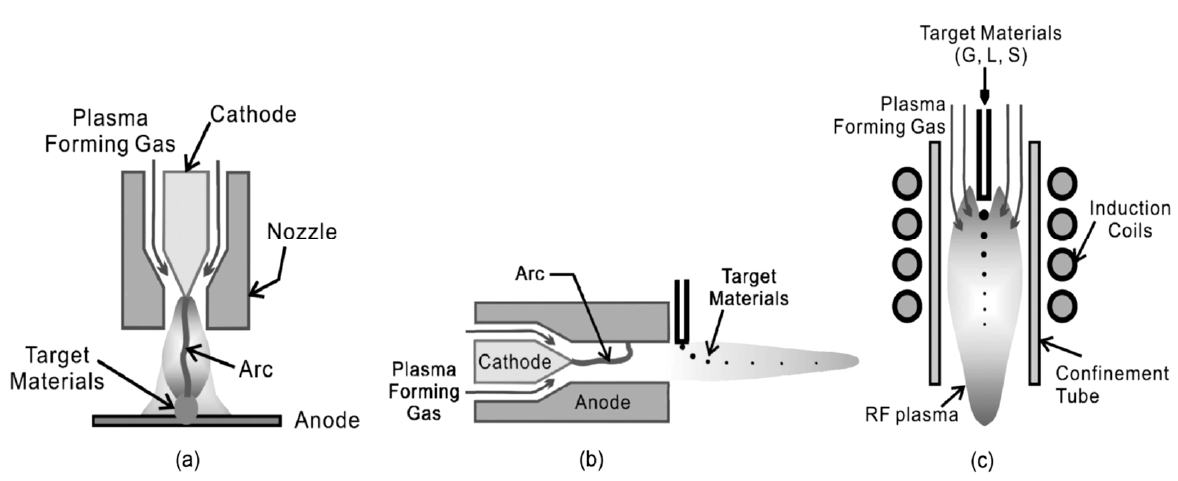
Figure 2. Schematic Diagrams of the Typical Thermal Plasma Torches Available for Synthesis of Nano-sized Powders. ( a )Transferred DC Plasma Torch, ( b ) Non-transferred DC Plasma Torch and ( c ) RF Plasma Torch. Reproduced from Ref. [11], an open access article.